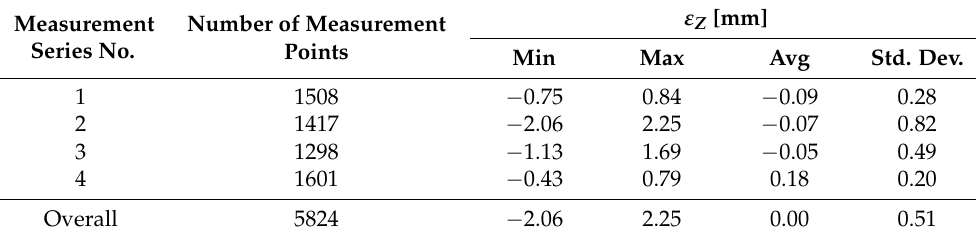
Table 6. Summary of the basic statistics of deviations in the direction of Z B axis of all measurement points registered in individual measurement